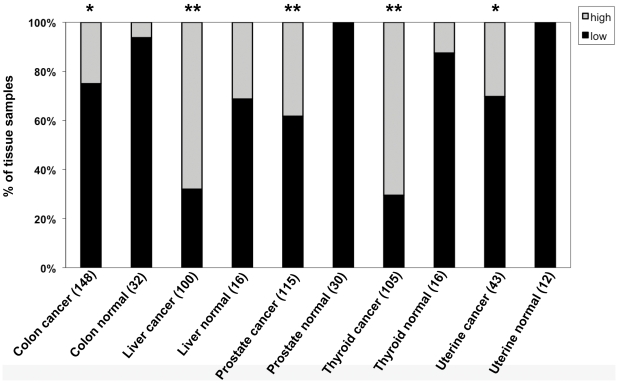
Elevated immunohistochemical expression of LEDGF/p75 protein in five tumor types compared to corresponding normal tissues.Tissue microarrays were stained with antibody against LEDGF/p75, and the individual cores were blindly scored using the following scale: 0 = no staining, 1 = low staining, 2 = moderate staining, 3 = strong staining. Scored tissues were pooled into two groups: low staining (scores 0 and 1, dark bars) and high staining (scores 2 and 3, light bars). The percentage of specimens in the two staining categories was plotted for tumor tissues compared to normal (including disease-free normal and normal adjacent) tissues. *P<0.05; **P<0.01. P values were determined with Fisher's exact test.